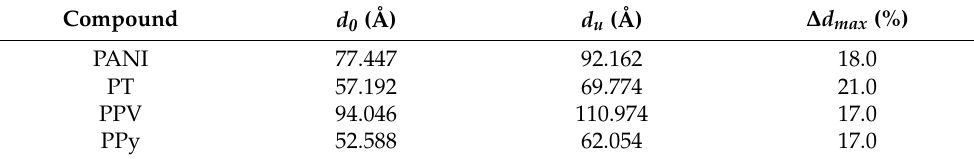
Table 1. Structural data of the systems before the deformations and at the point of imminent rupture.